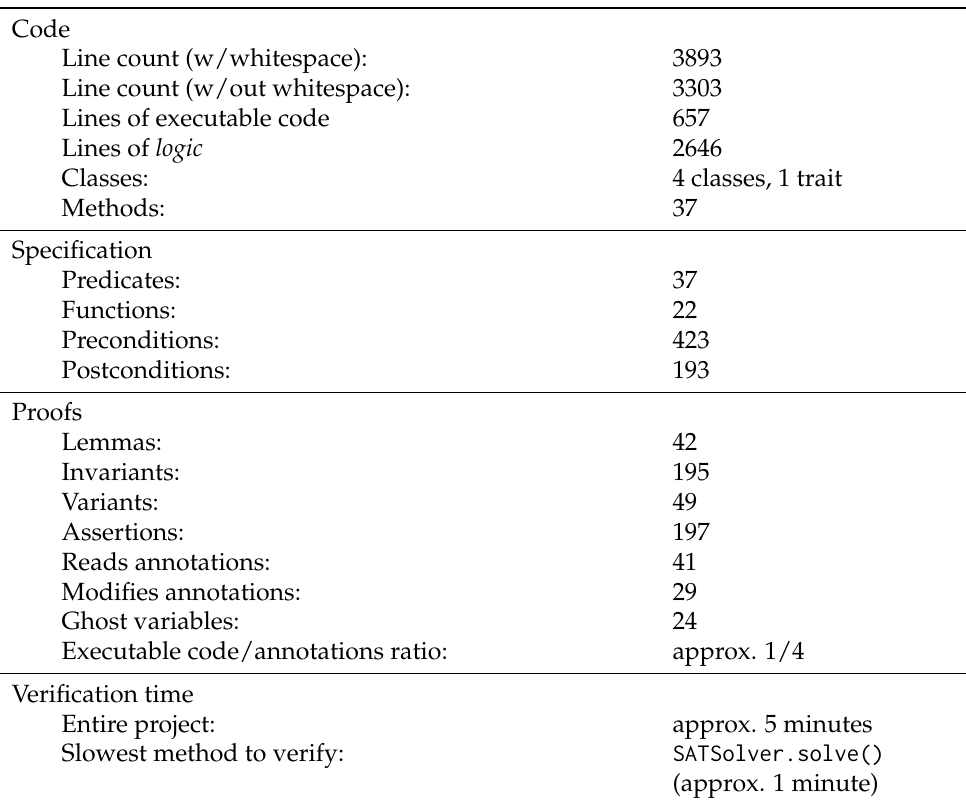
Table 2. Various statistics for our verified DPLL